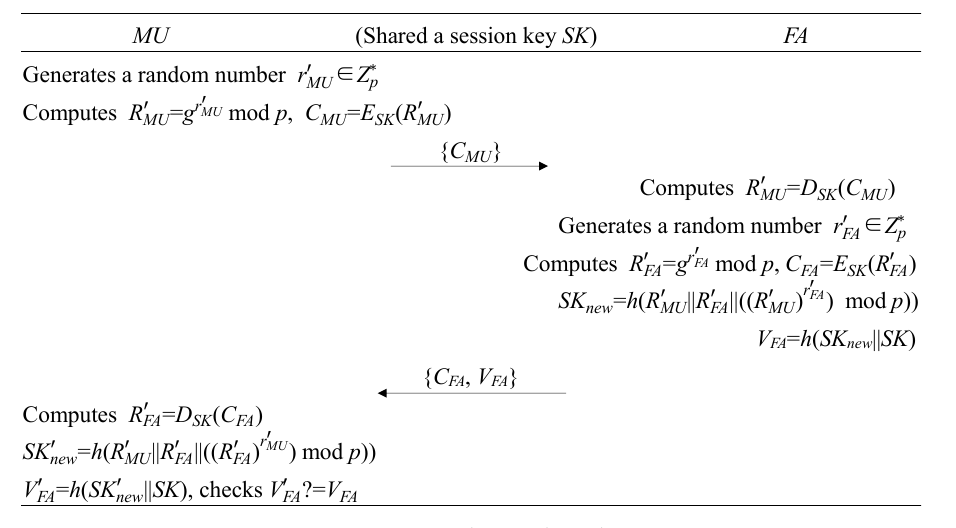
Figure 2. Session key update